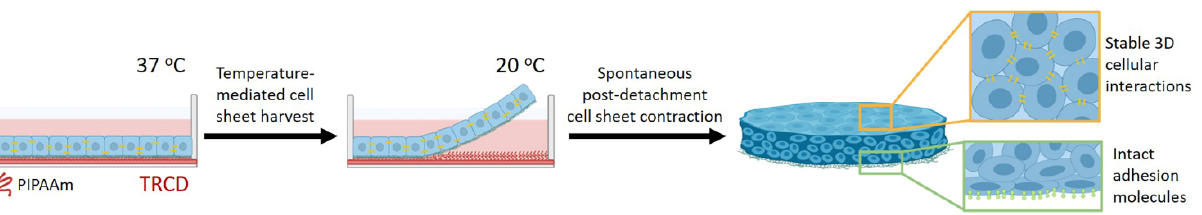
Figure 3. Cell sheet fabrication leads to increased three-dimensional (3D) cellular interactions and intact adhesion molecules at the construct surface [156,157,160,161]. Temperature-mediated cell detachment from poly( N -isopropylacrylamide) (PIPAAm)-grafted temperature-responsive culture dishes (TRCDs) enhances cellular interactions (yellow linkers) through spontaneous post-detachment sheet contraction and retains intact surface adhesion molecules (green markers). Created with BioRender.com (accessed on 1 March